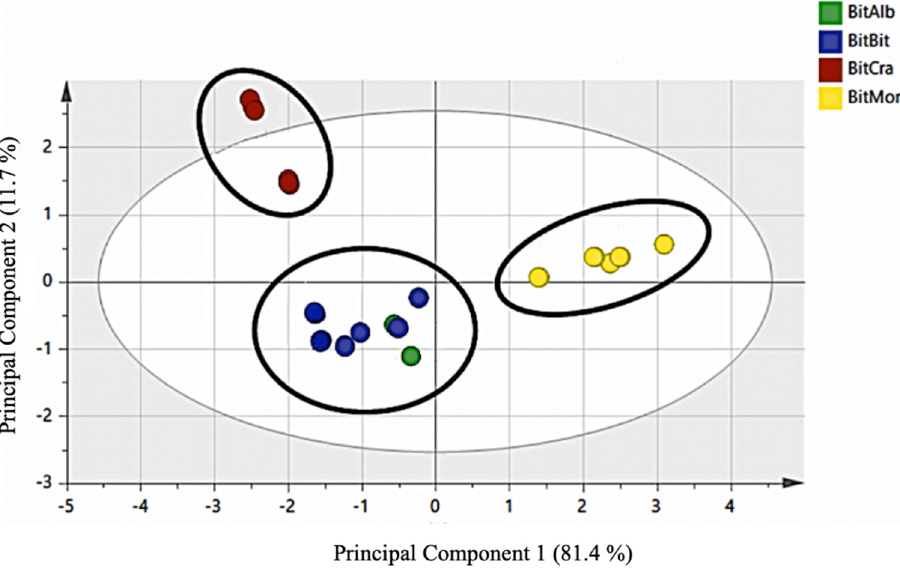
Figure 2. Score plot of PCA analysis performed using the essential oil components. Principal components 1 and 2 represented 93.1% of the variance.